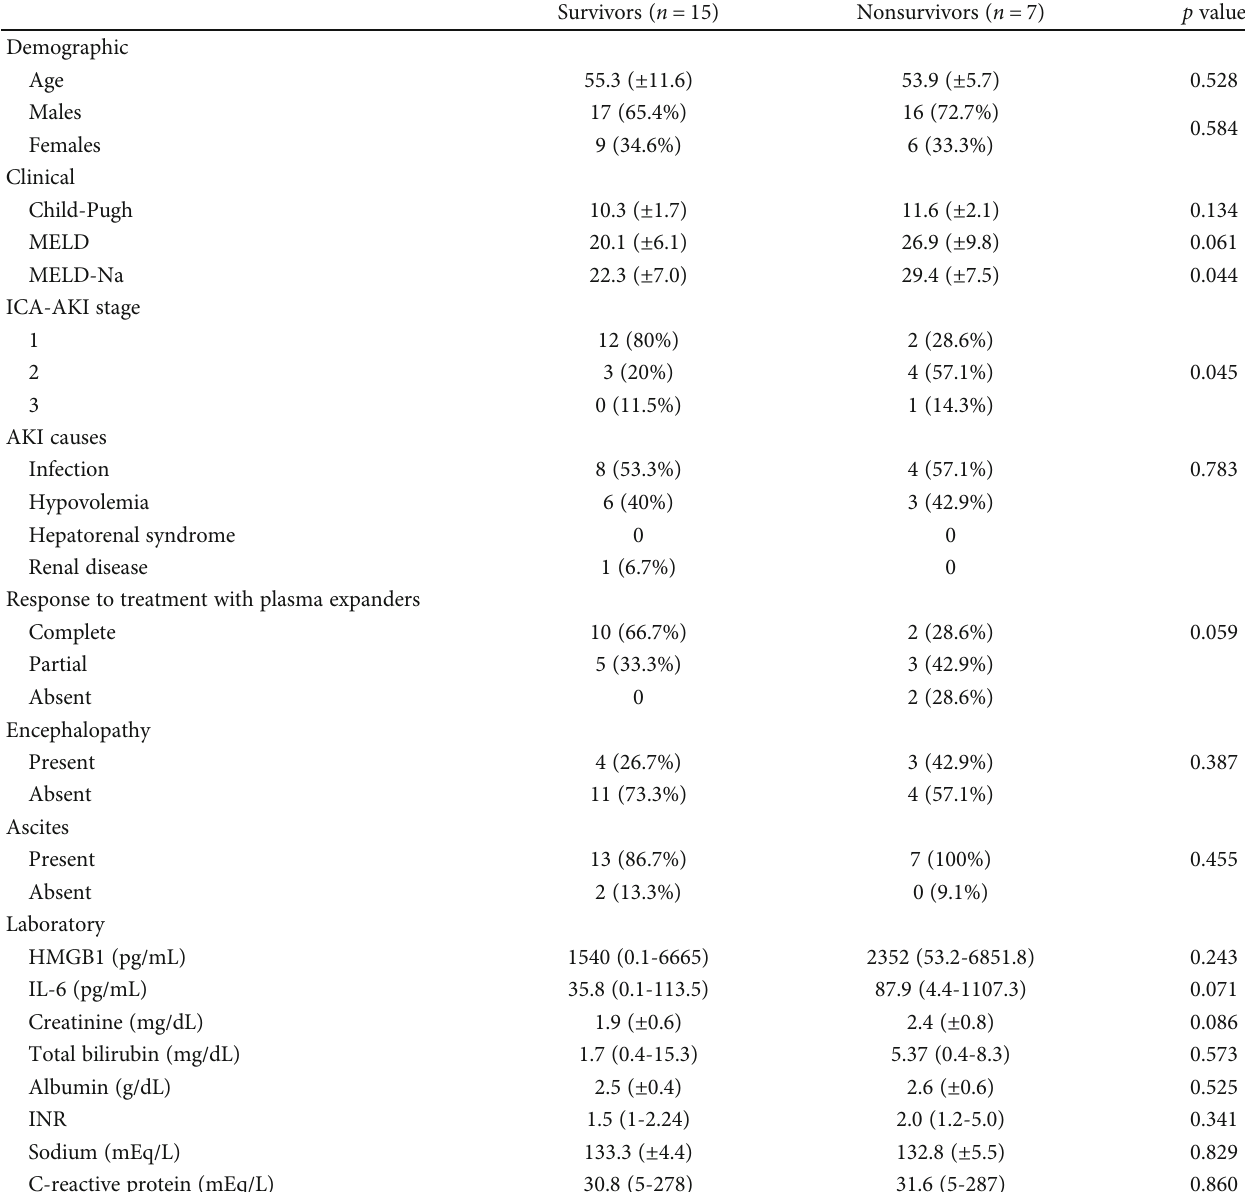
Table 3: Comparison of demographic, clinical, and laboratory variables between survivors and nonsurvivors at three